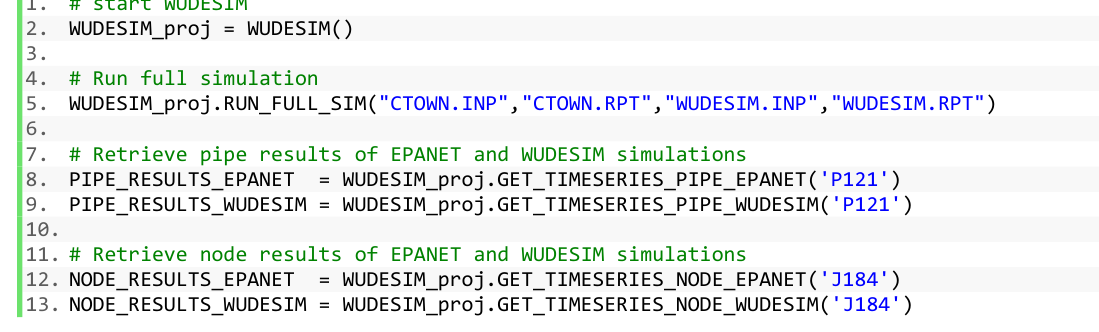
Figure 2. Example script for running a full simulation and retrieving the results.